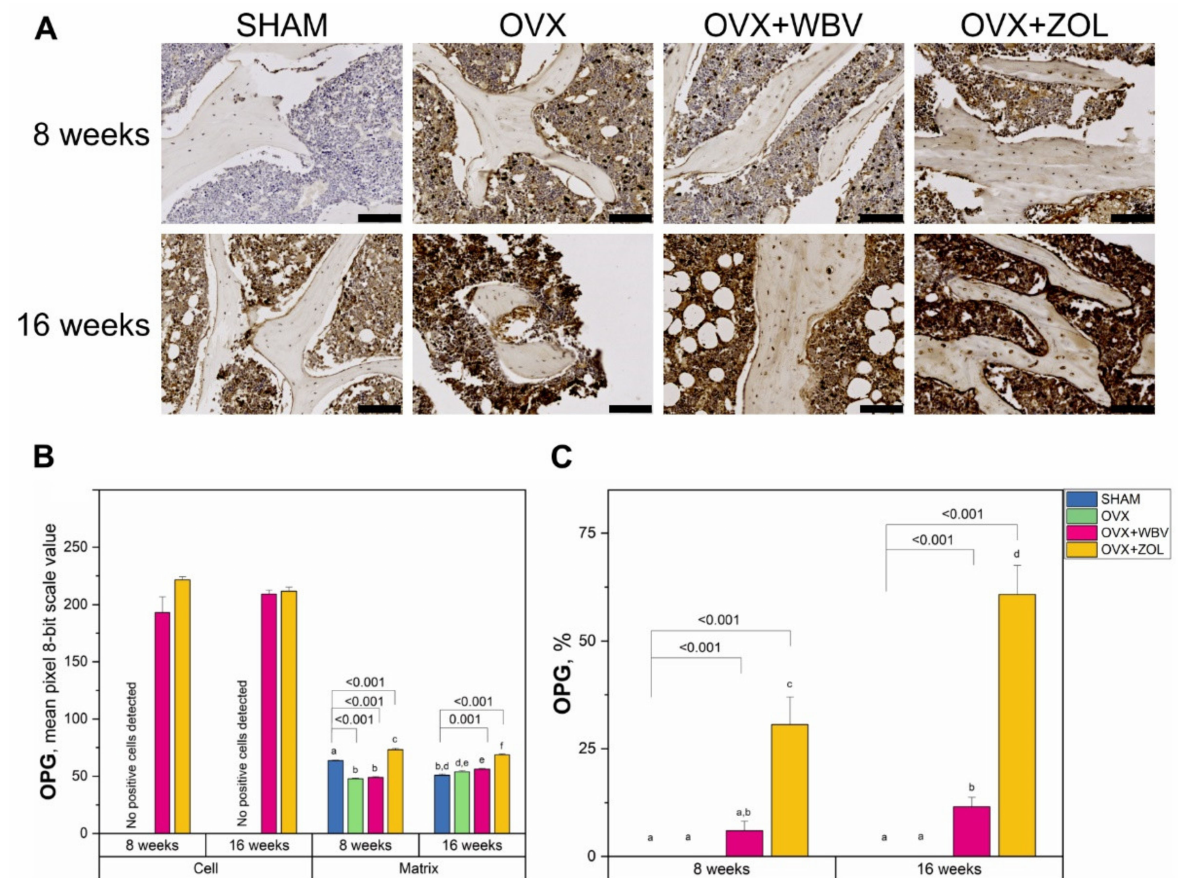
Figure 4. ( A ) Representative images of the immunohistochemical reactions for osteoprotegerin (OPG) in the trabecular bone of femora from controls (SHAM surgery), ovariectomized rats (OVX), ovariectomized rats with whole body vibration (OVX + WBV), or Zoledronic acid (OVX + ZOL). All the scale bars represent 100 µ m. ( B ) Bar graphs show the intensity of expression of OPG in cells (osteocytes) and matrix measured by the comparison of the pixel brightness value in the microscopic images converted to 8-bit grayscale—the higher the pixel value, the higher the intensity of the immunohistochemical reaction. ( C ) The percentage of cells with a positive response. Data are presented as mean ± SE with corresponding statistical analysis. Statistically significant differences between groups (at p < 0.05) are indicated by a, b, c, d, e, and f letters. Dunnett post-hoc significant p -values are placed over